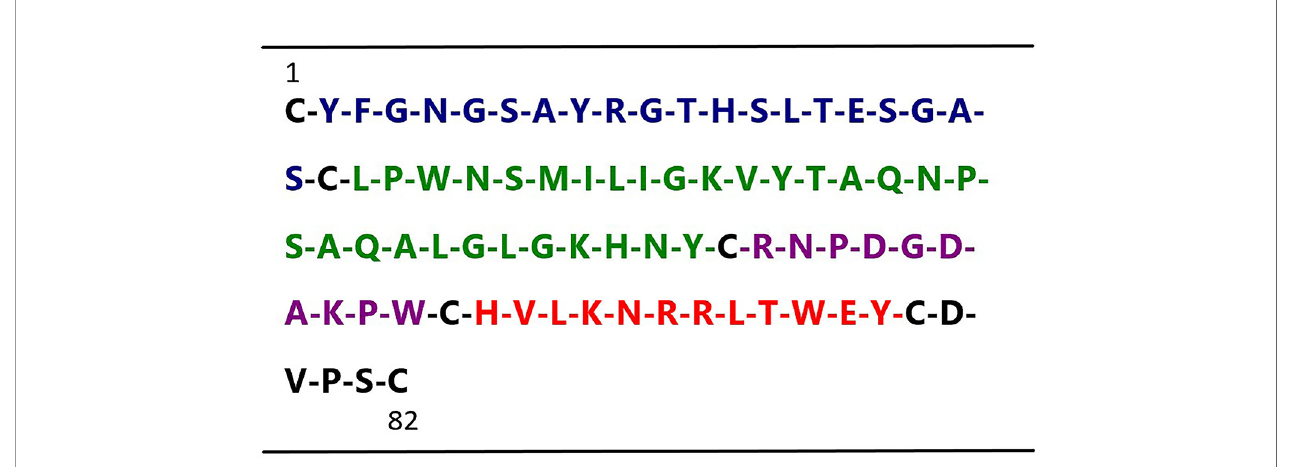
FIGURE 1 | Sequence of human t-PA kringle 2. The fi gure shows the primary sequences of the four t-PA kringle 2-derived peptides, highlighted in blue Peptide 1 (Tyr2 – Ser21), green Peptide 2 (Leu23 – Tyr52), purple Peptide 3 (Arg54 – Trp63) (named TKII-10), and red Peptide 4 (His65 – Tyr76)(named TKII-12),